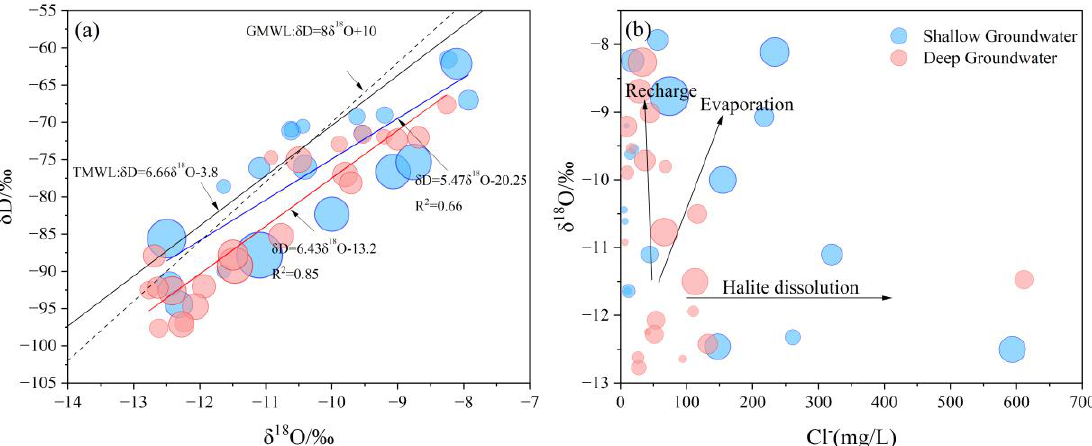
Figure 7. ( a ) Bivariate plot of δ D and δ 18 O in groundwater samples with TDS concentrations indicated as bubbles; ( b ) Bivariate plot of Cl and δ 18 O in groundwater samples with fluoride concentrations indicated as